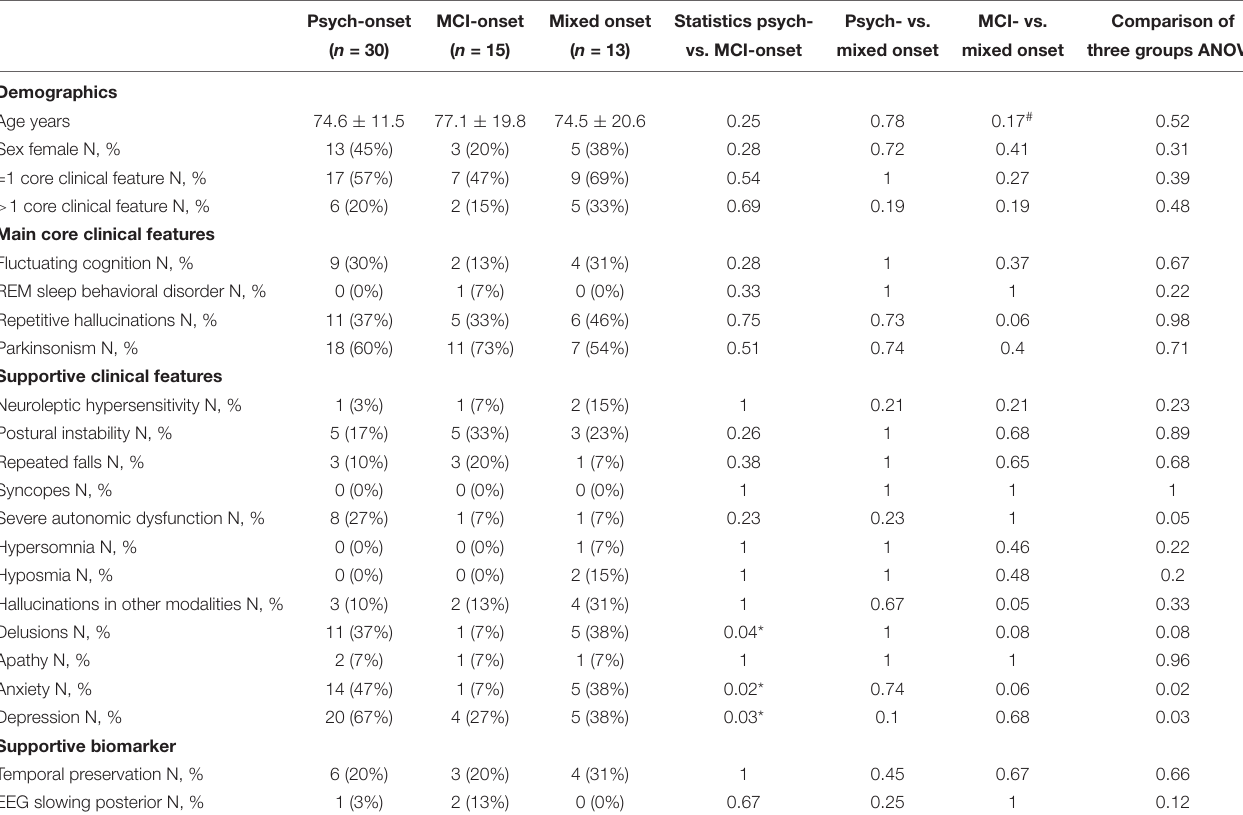
Psych-onset MCI-onset Mixed onset Statistics psych- Psych- vs. MCI- vs. vs. MCI-onset mixed onset mixed onset three groups